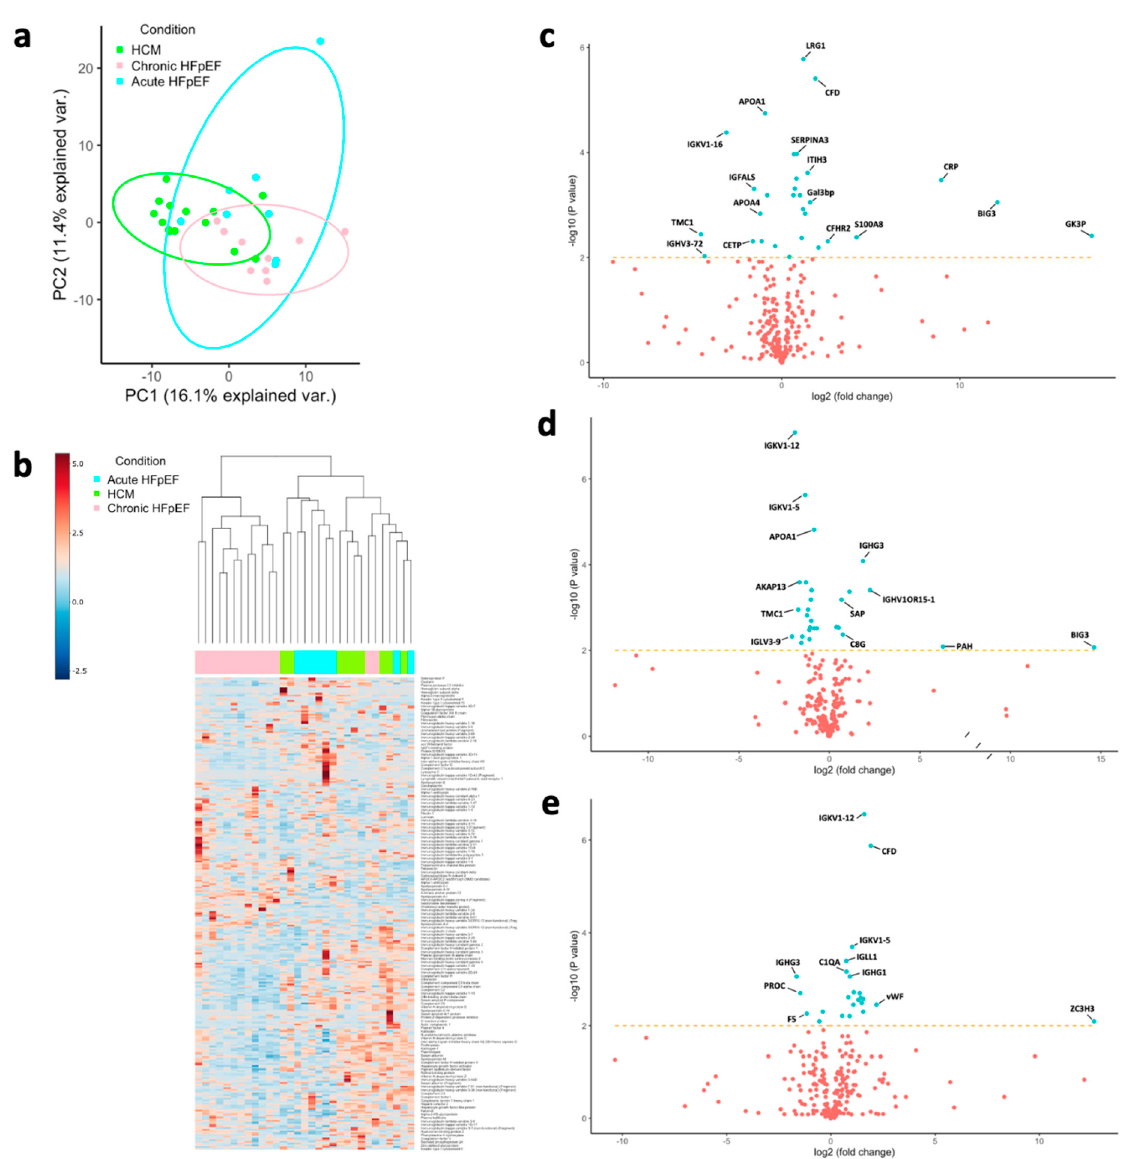
Figure 1. Overviews of differential expression analysis. ( a ) Principal component analysis (PCA) plot of proteomic data in HCM, chronic and HFpEF groups. ( b ) Heatmap of individual samples with hierarchical clustering dendrogram of proteome profiles across HCM, chronic and acute HFpEF groups. Volcano plots of proteomic data in ( c ) acute HFpEF vs. HCM, ( d ) chronic HFpEF vs. HCM, and ( e ) acute HFpEF vs. chronic HFpEF. Differential expression (DE) analysis was performed by fitting a linear regression model adjusted for age, gender and diabetes. DE proteins were defined as Benjamini–Hochberg adjusted p value < 0.01, as indicated by the proteins above the cut-off